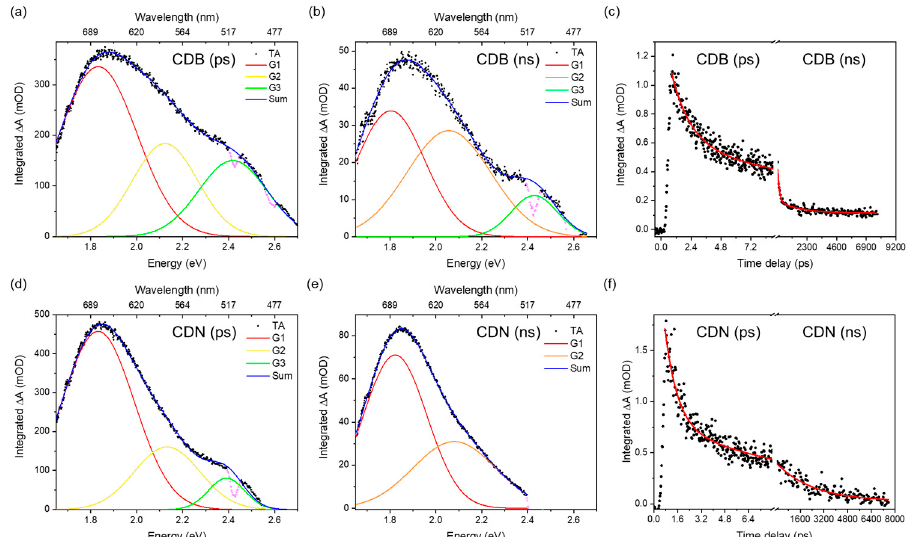
Figure 6. Deconvolution of integrated TA spectra in the picosecond and nanosecond domain for CDB ( a , b ) and CDN ( d , e ); integrated TA signal decays in the picosecond and nanosecond time range for CDB ( c ) and CDN ( f ). The purple negative narrow peaks in the integrated ∆ A spectra ( a , b , d , e ) are due to spurious signals originated from the optical parametric amplifier during the pump generation.